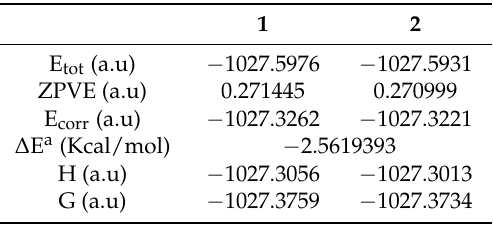
Table 6. The total energy (E tot ), zero point energy correction (ZPVE), corrected total energy (E corr ) and energy difference ( ∆ E) between the two isomers 1 and 2 .